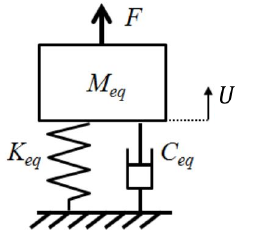
Figure 17. Mass–spring